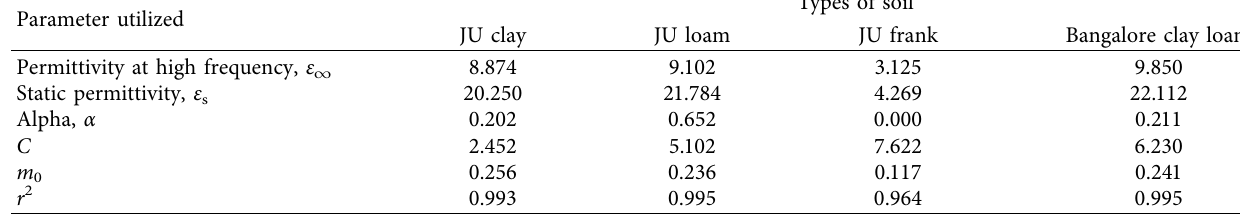
Table 5: List of all four soils investigated and their respective dielectric characteristics were simulated by the parameters utilized. Parameter